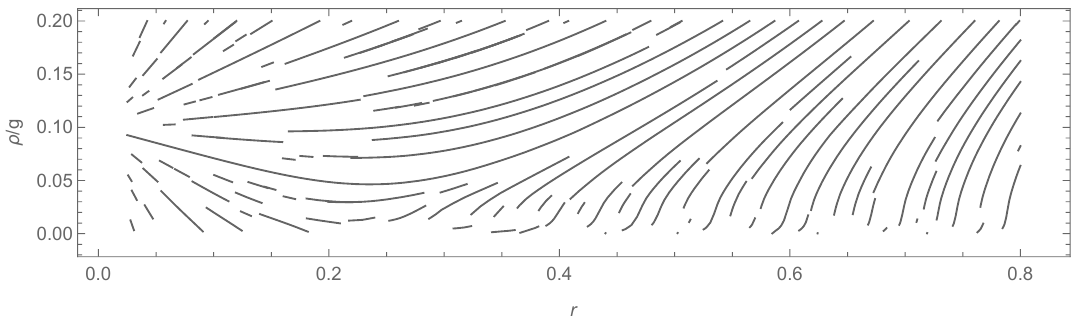
Figure 5 . Force lines (gradient flows) of a Type III